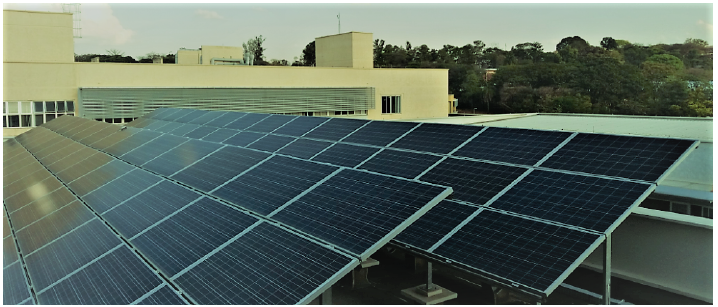
Figure 2. UFMG engineering school